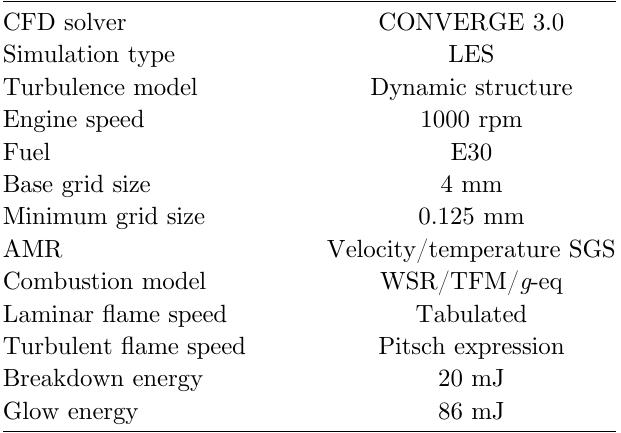
Table 3. Summary of the numerical setup of the engine simulations.